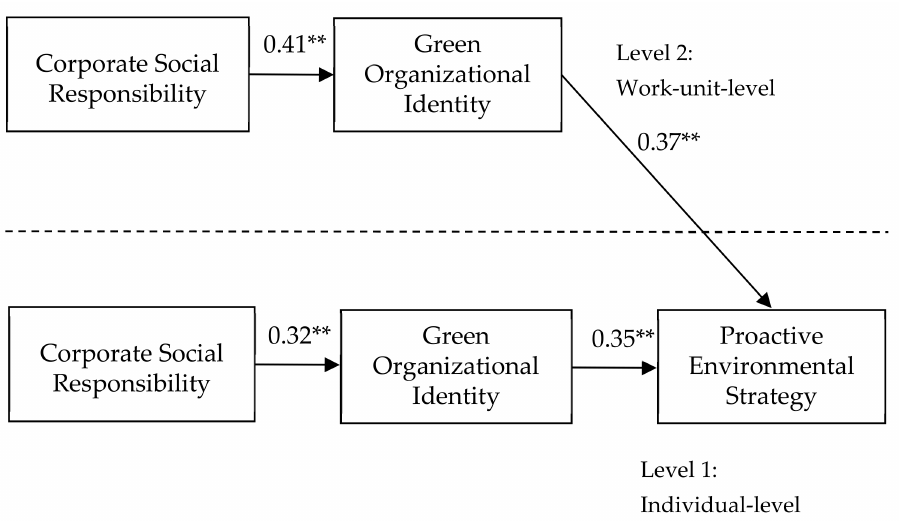
Figure 2. Analysis results of this research. Note: ** = p <